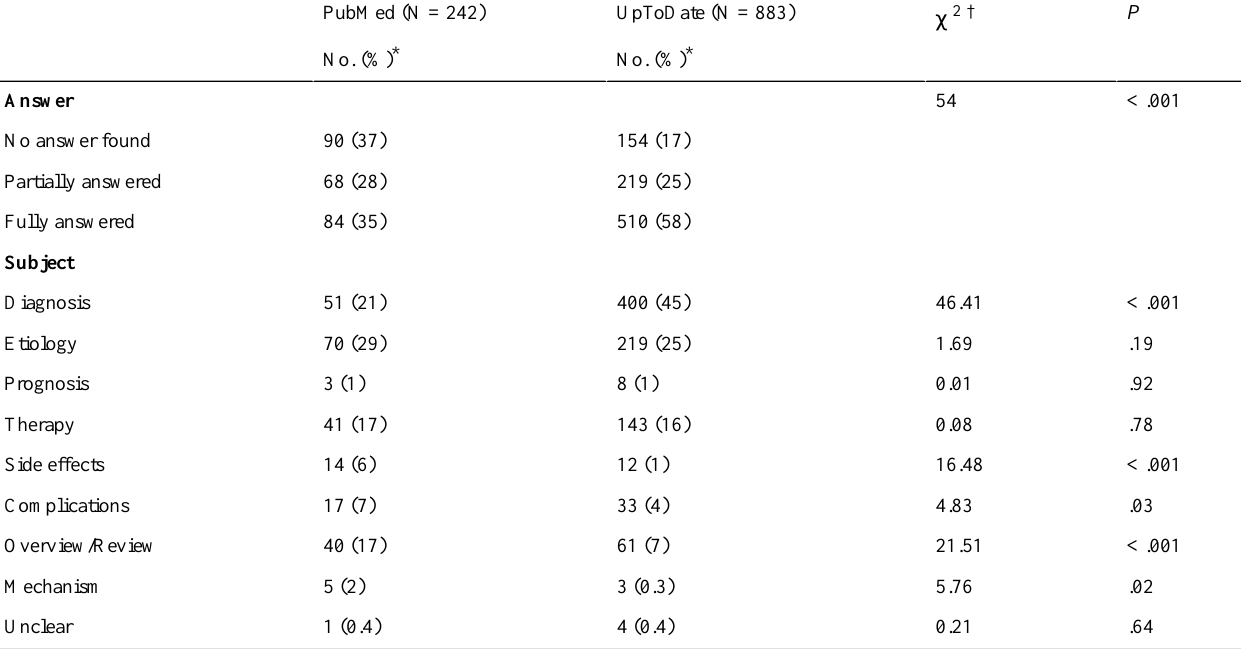
Chi-square of difference between UpToDate and